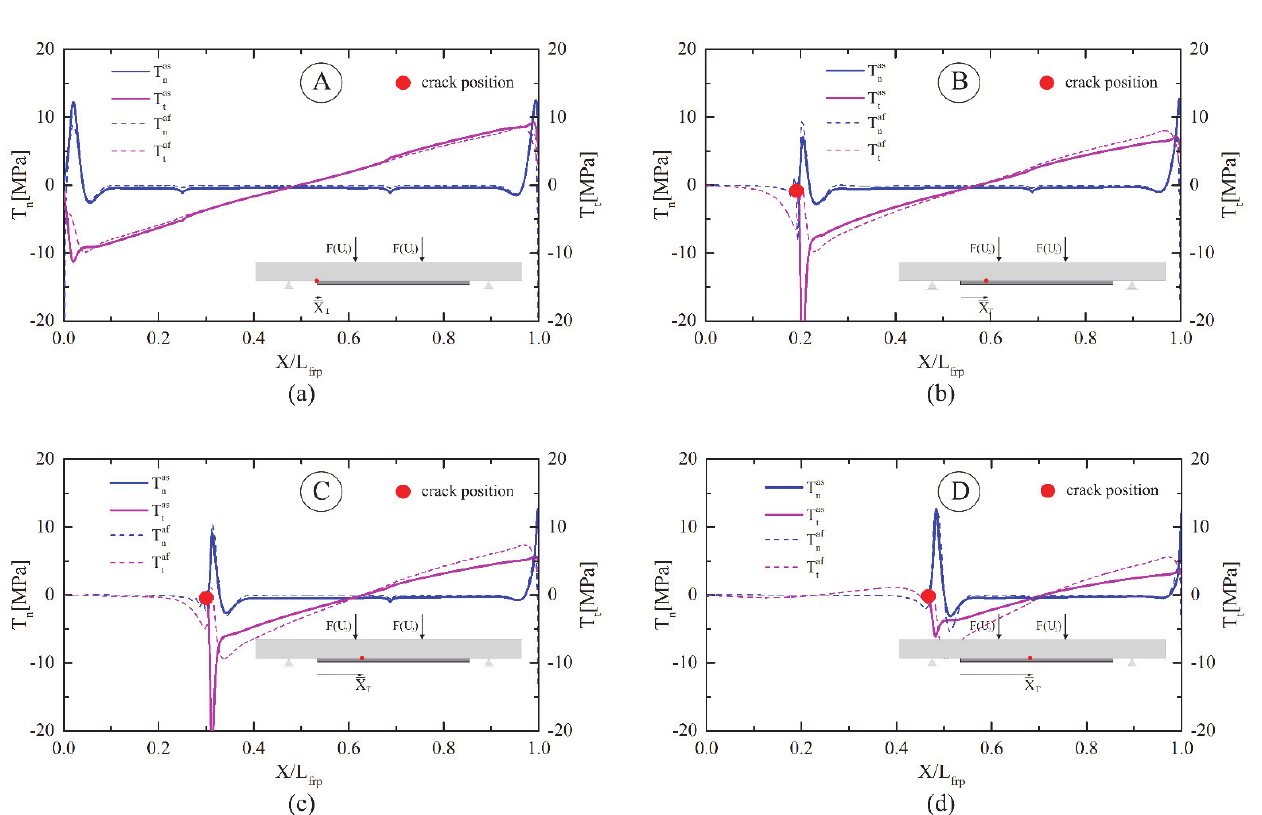
Figure 9: Comparisons in terms of interfacial tractions across the two cohesive interfaces for different positions of debonding front: X =0mm as